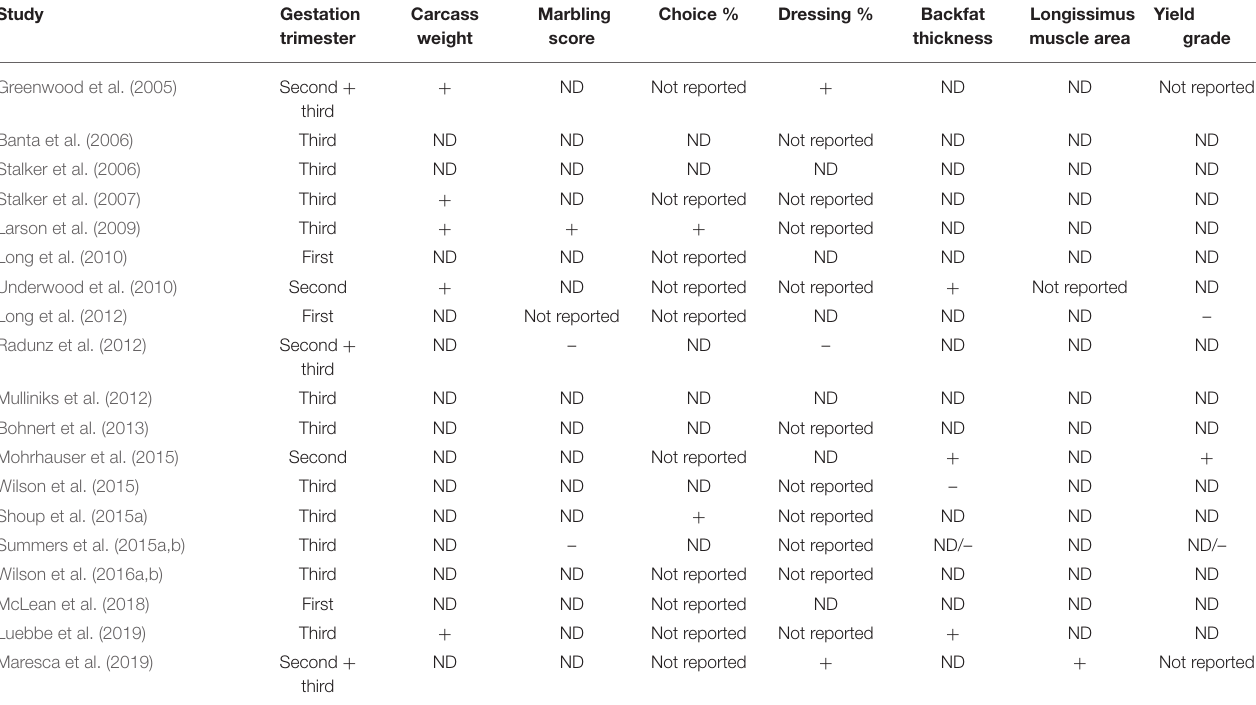
TABLE 2 | Studies ( n = 19) reporting positive ( + ) or negative (–) effects, or no differences (ND; P > 0.10) of maternal protein and/or energy supplementation during gestation on carcass characteristics of